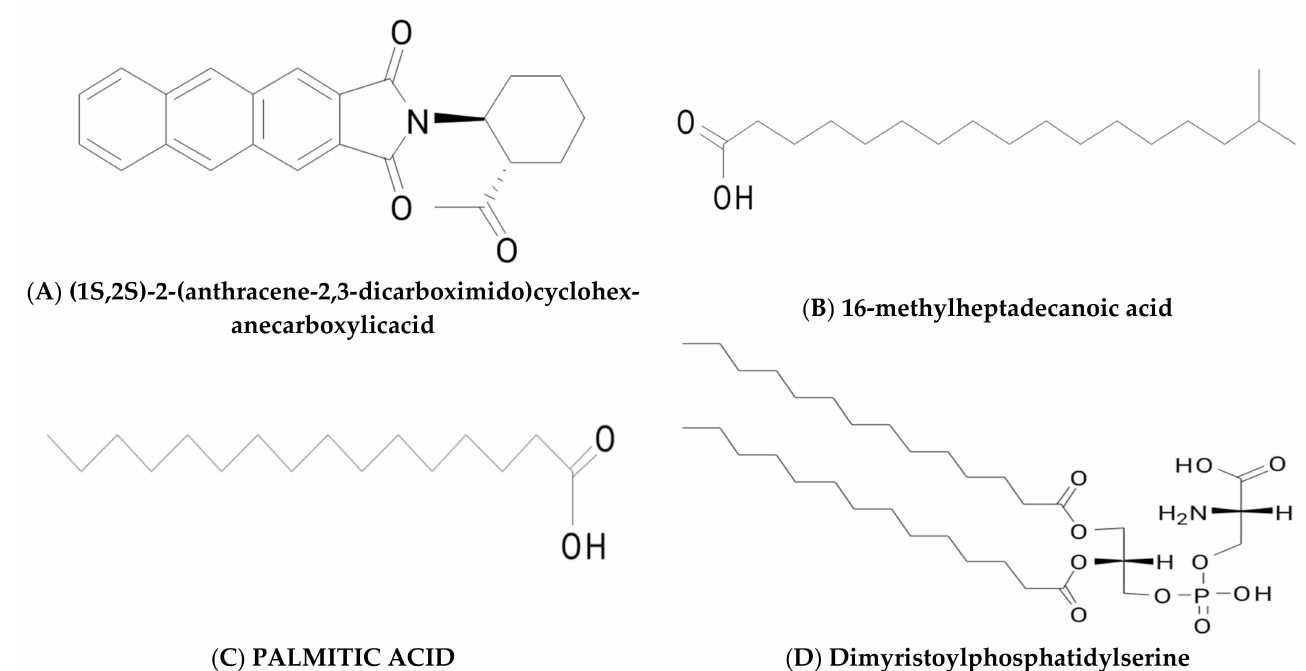
Figure 5. ( A – D ) shows the structures of fatty